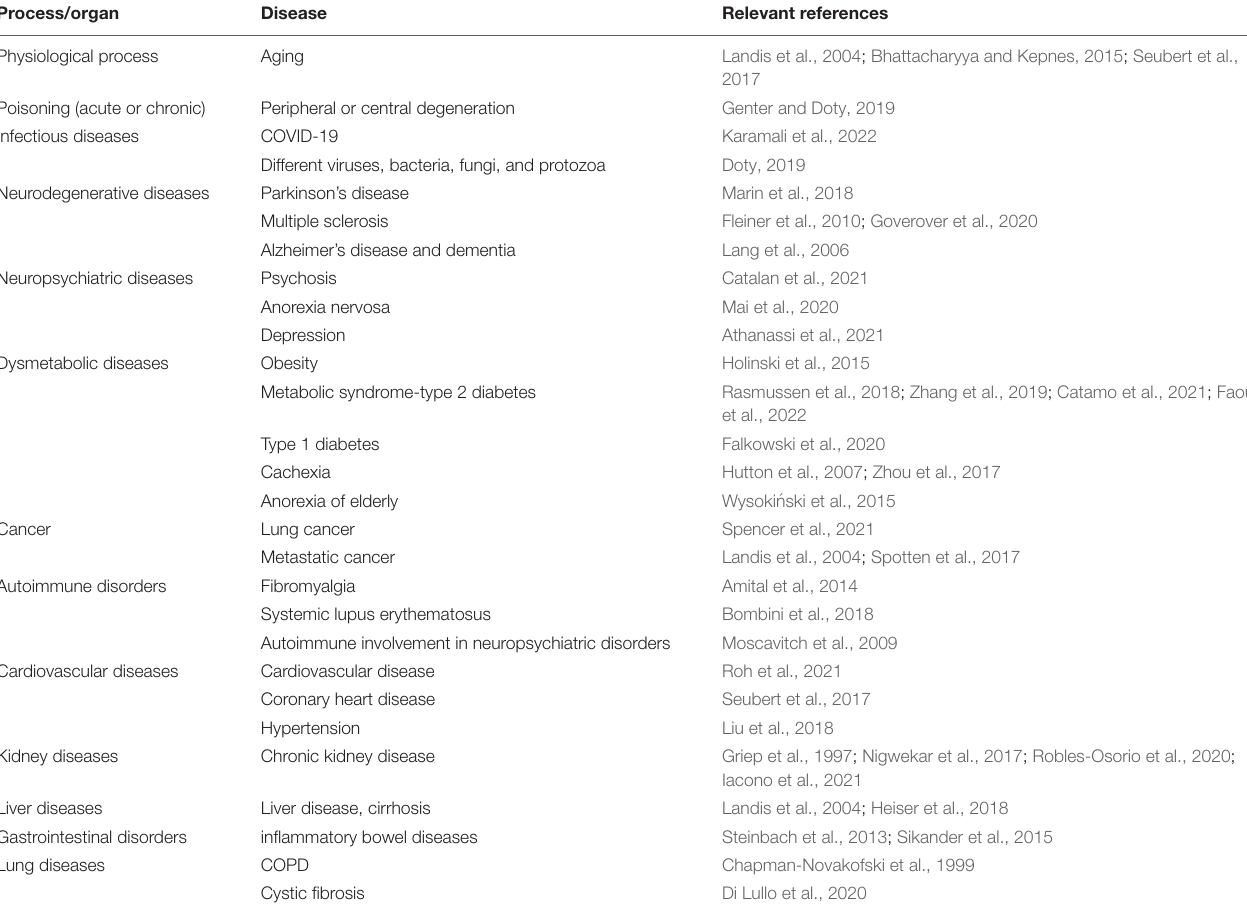
TABLE 3 | List of the diseases in which olfactory and/or taste impairments are most frequently detected (see text for additional